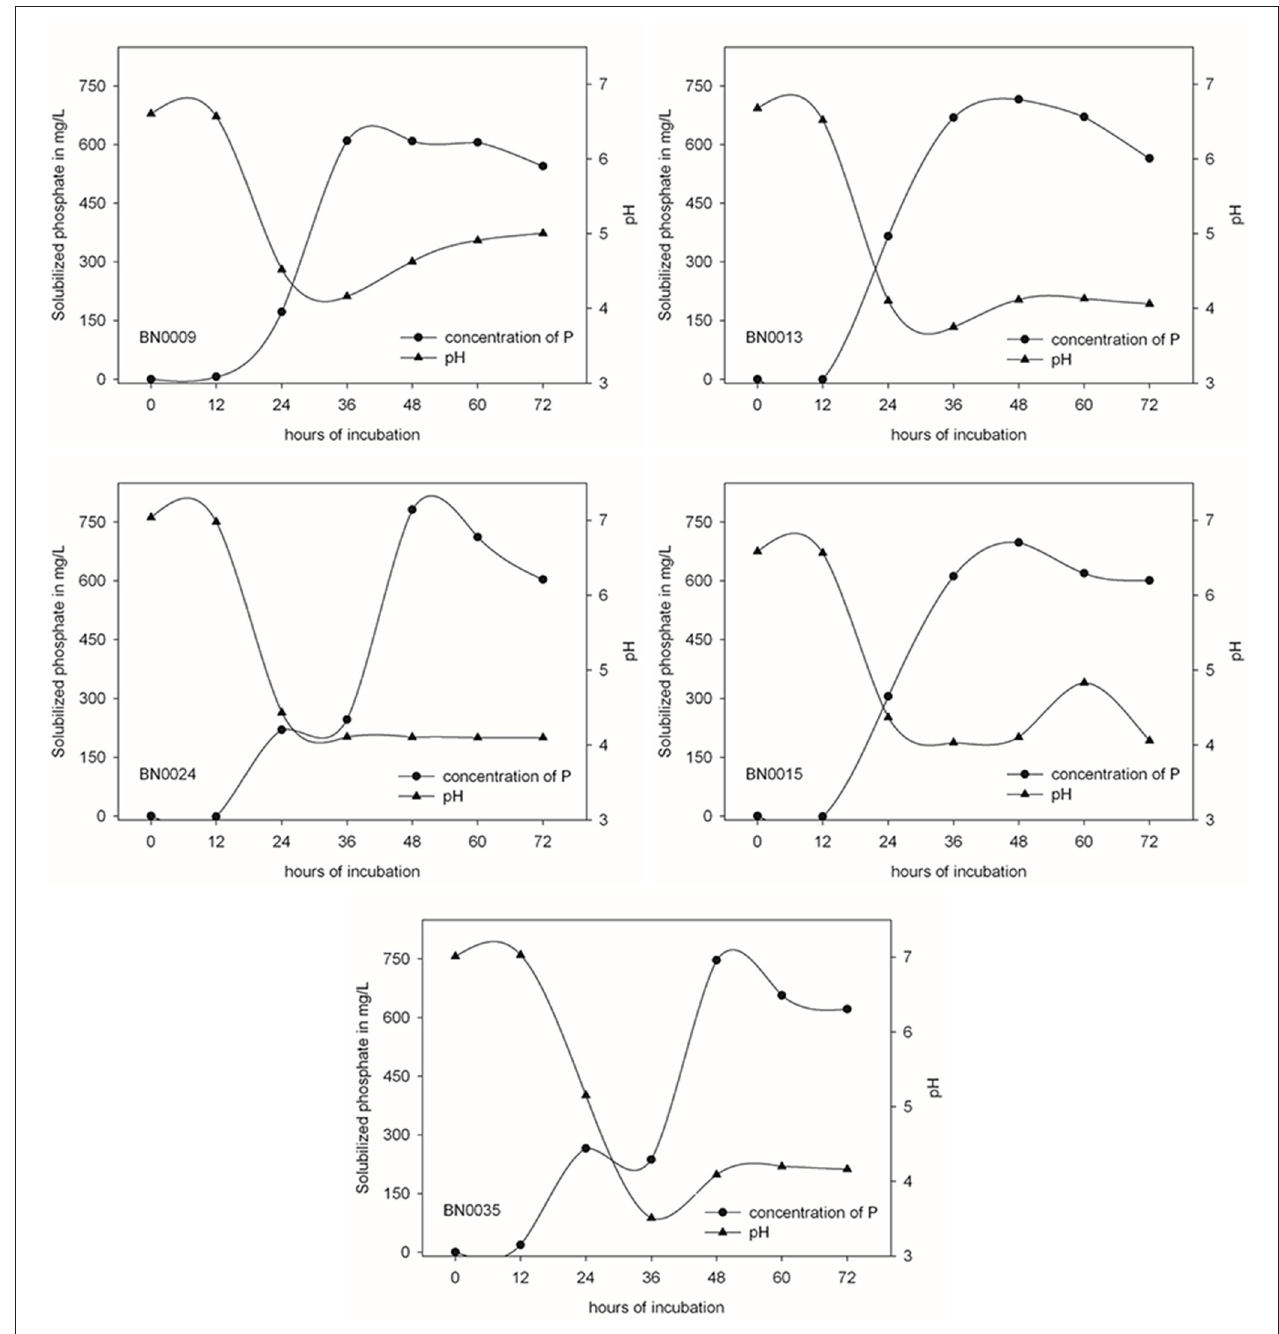
FIGURE 2 | Kinetics of phosphate solubilization and pH changes of the five BN isolates in time, measurements every 12h during 3 days of incubation.